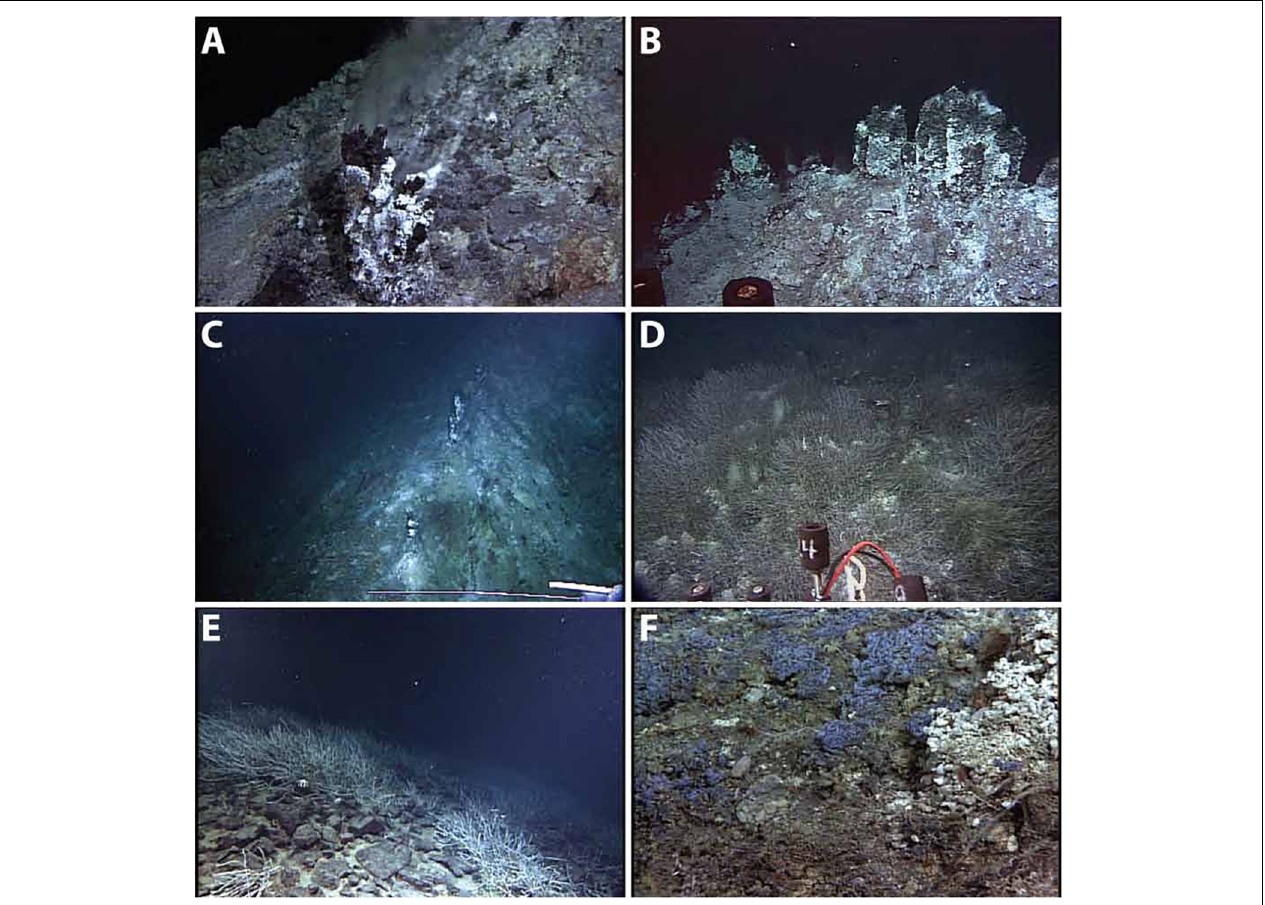
FIGURE 9 | Video framegrabs of features at the Sea Cliff hydrothermal vent field. Images A , B , D, and F are ∼ 2–3 m across and images C and E are ∼ 5–10 m across. Locations are indicated on Figure 8 . (A) Active anhydrite/saponite/amorphous silica chimney. Clear venting fluid is ∼ 305 ◦ C. Image taken at 2721 m depth